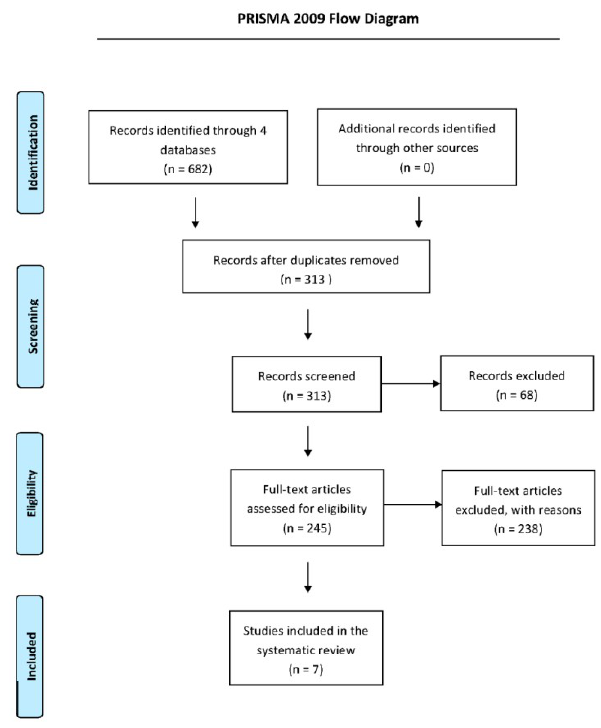
Figure 1. Study selection flow diagram. Table 1. Characteristics of included studies.